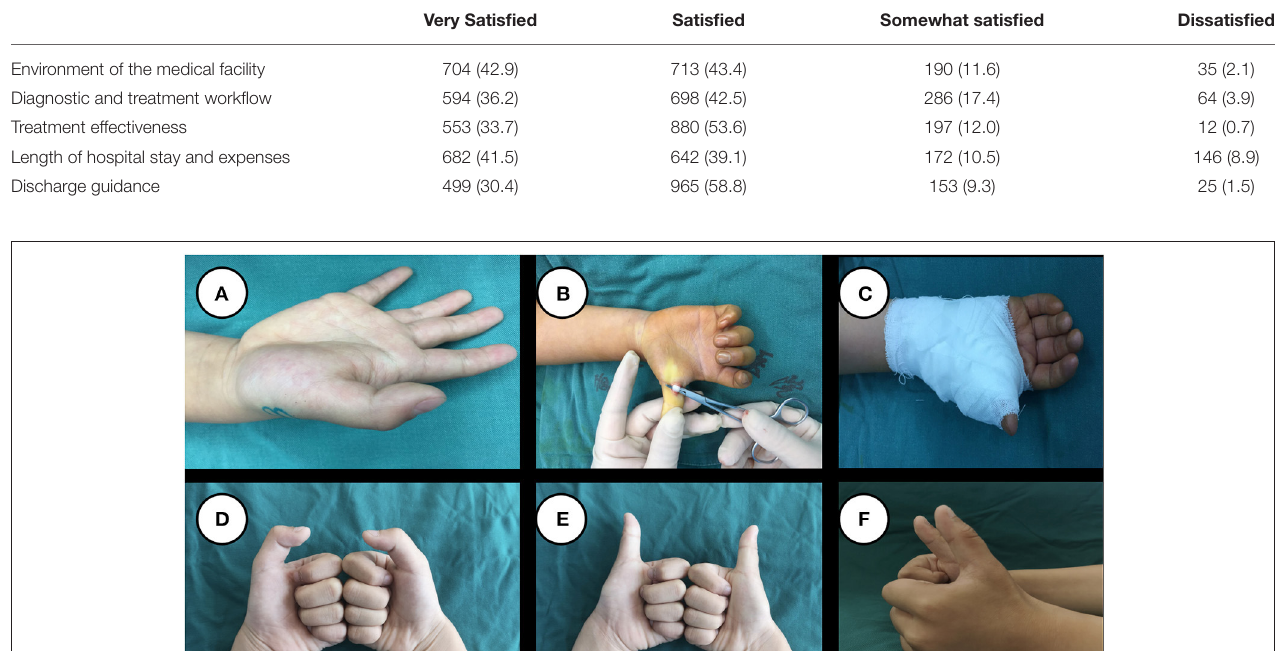
TABLE 2 | Patient satisfaction [n(%)].